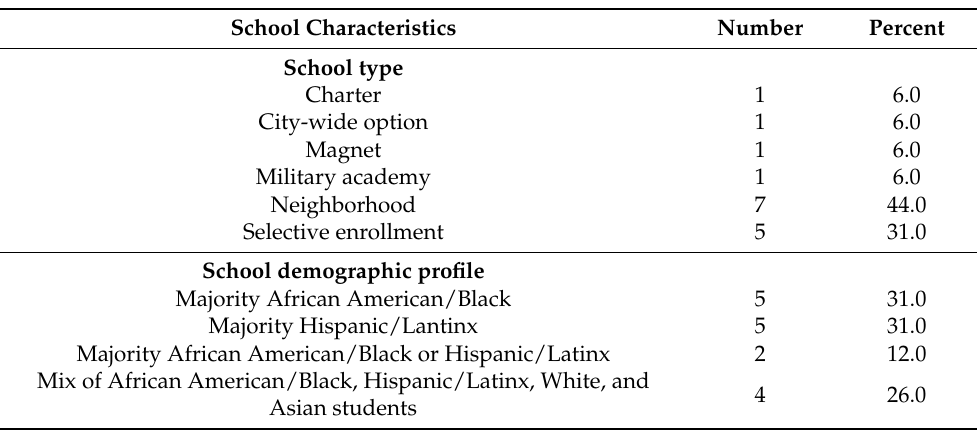
Table 1. Types of schools included in this study, n = 16.